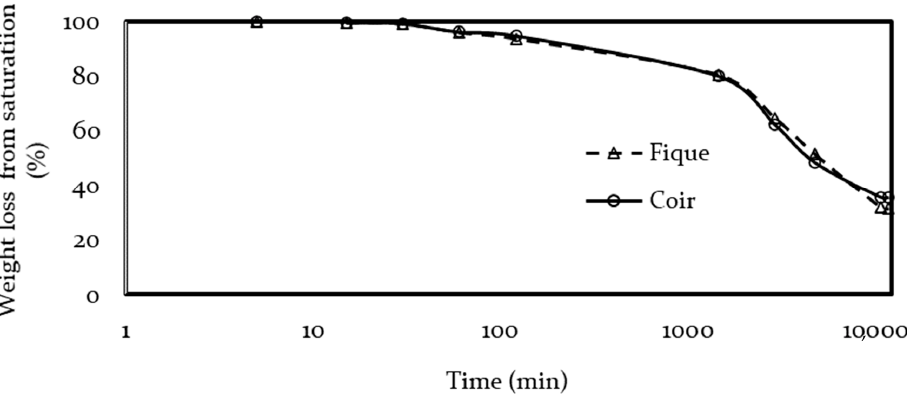
Figure 10. Panels desorption rates.